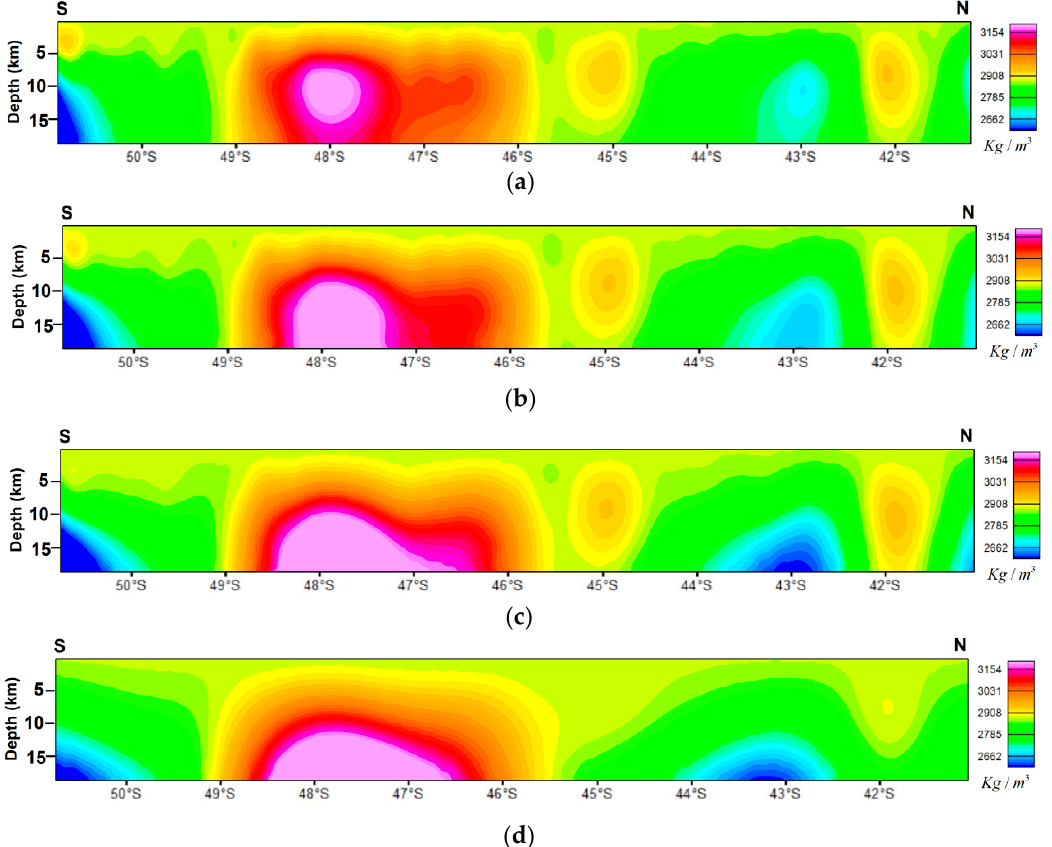
Figure A2 : Some of the models that were recovered from changing the exponent of the Tikhonov parameter during 3D inversion for ( a ) 2, ( b ) 2.5, ( c ) 3 and ( d ) 4.